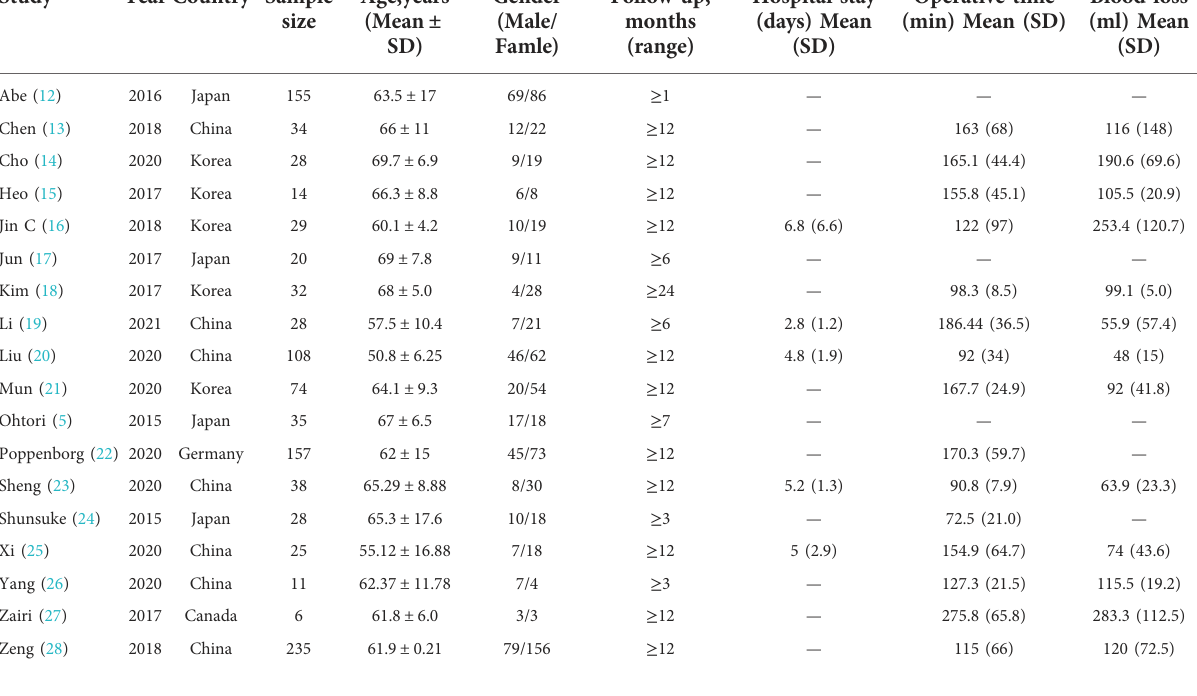
TABLE 2 Characteristics of TLIF